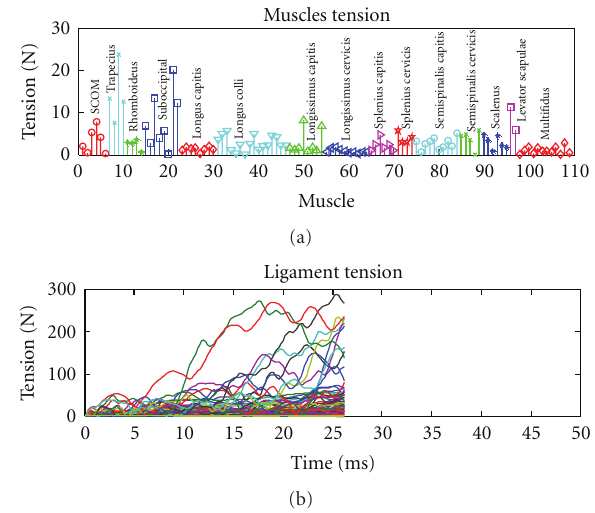
Figure 9: One initial candidate of randomly selected muscle tensions for the GA optimization search. (a) Muscle tension values for each one of the muscles in the complex, grouped by color. (b) Tension in ligaments as a function of time. The simulation was aborted at 26ms due to violation of physiological range of movement in the complex. The tensions in ligaments are increasing in an unstable